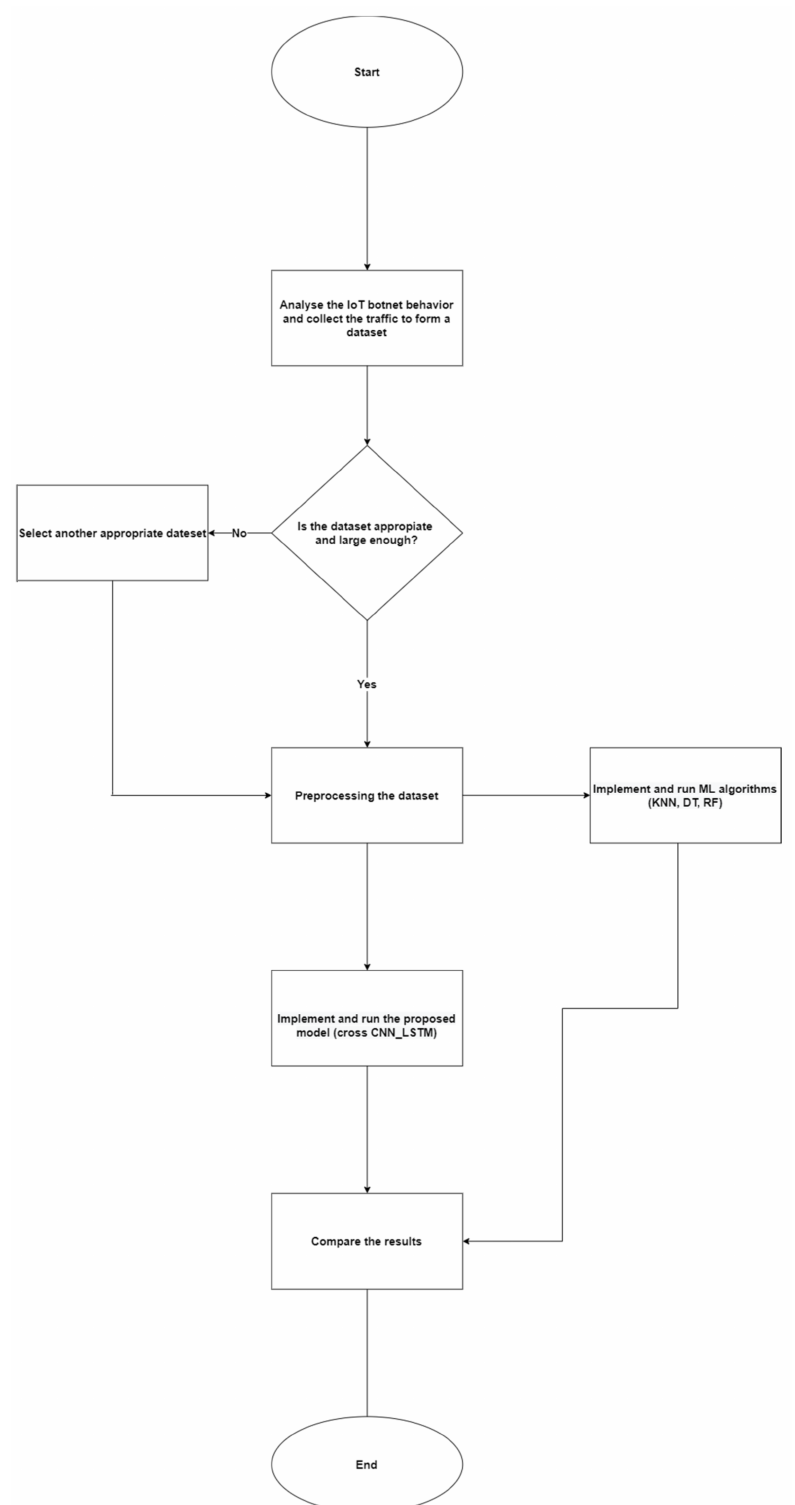
Figure 4. A comprehensive scheme of the used